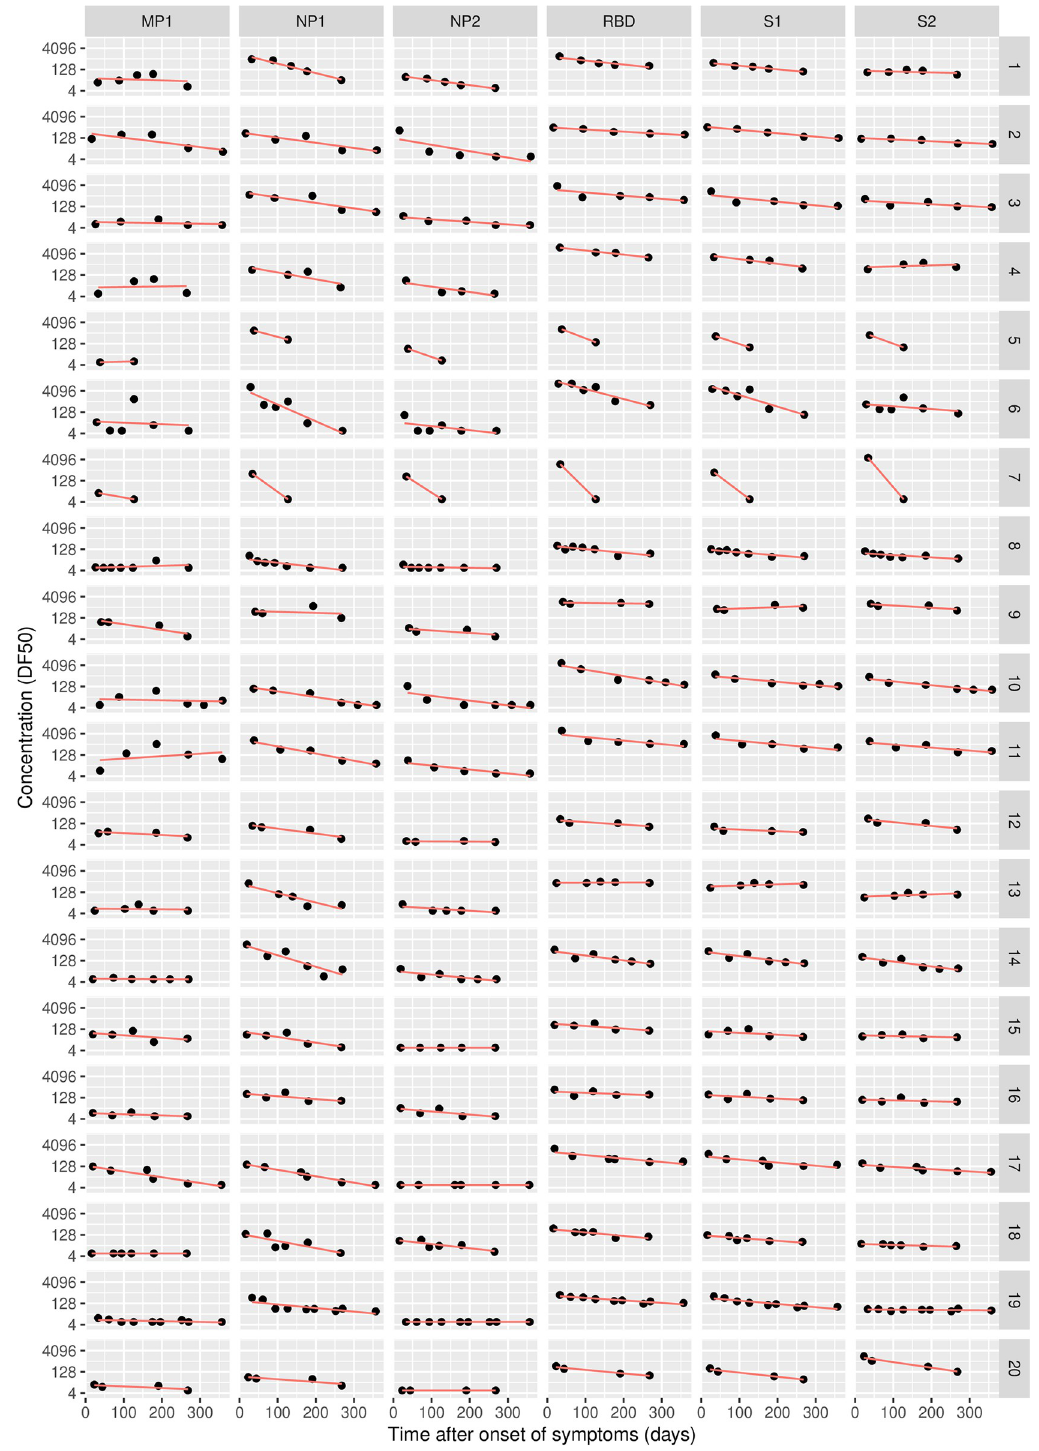
Fig 3. Antibody concentrations over time for 20 naturally infected subjects.